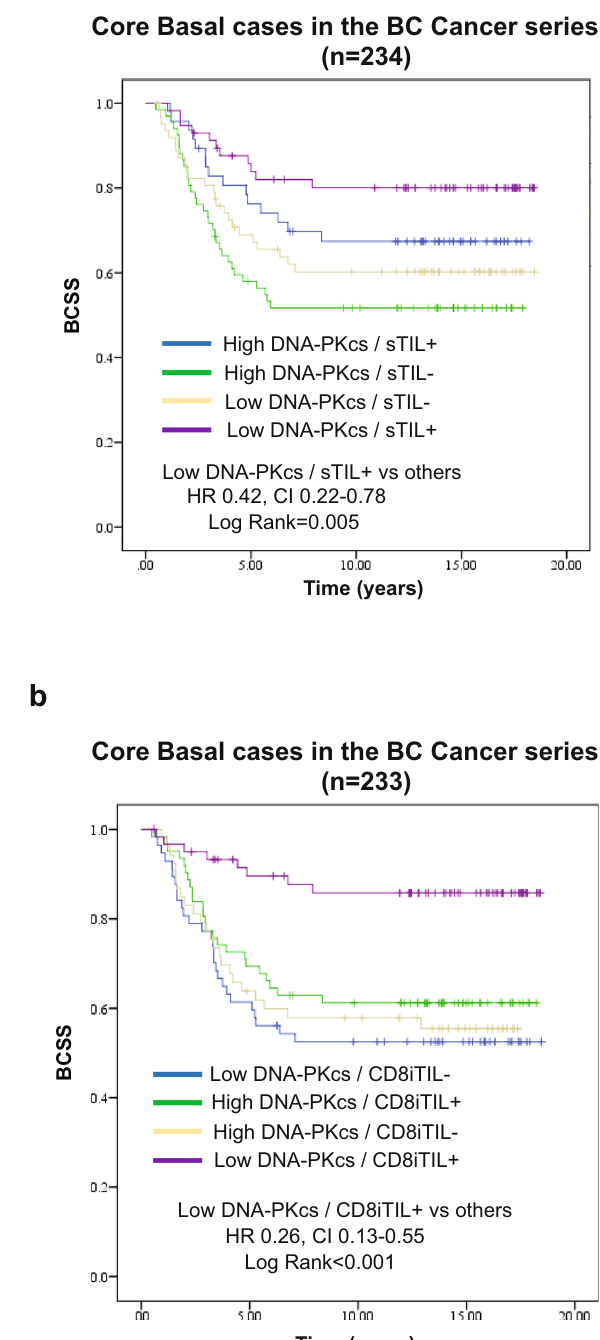
Fig. 4 Prognostic strati fi cation of core basal cases by DNA-PKcs and immune biomarkers in the BC Cancer series. a Within core basal tumors, the presence of sTILs in combination with low DNA- PKcs expression is associated with better BCSS. b Within core basal tumors, the presence of CD8 + iTILs in combination with low DNA- PKcs expression is associated with better BCSS. Abbreviations: IHC immunohistochemistry, BCSS breast cancer-speci fi c survival, sTILs stromal tumor-in fi ltrating lymphocytes, iTILs intraepithelial tumor- in fi ltrating